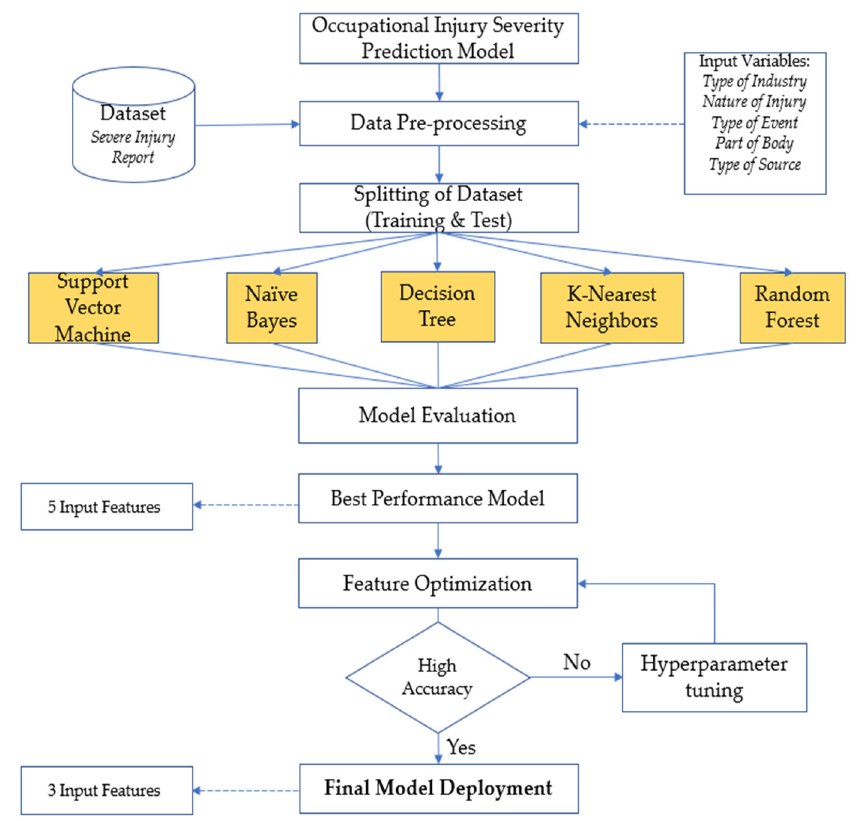
Figure 2. The overall research methodology.